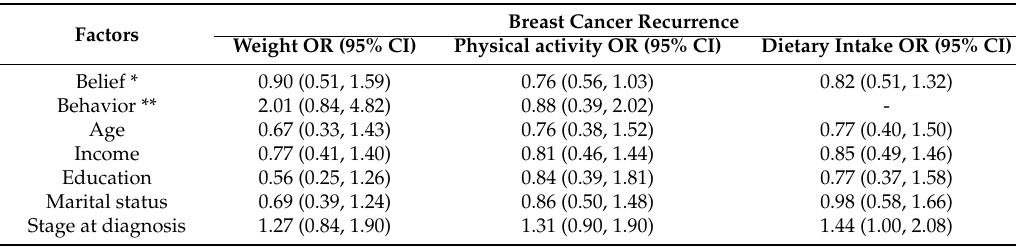
Table 4. Relationship between breast cancer recurrence and risk reduction beliefs and behaviors: multiple logistic regression